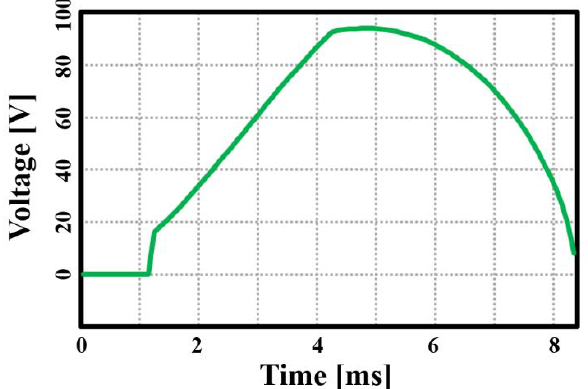
Figure 6. Voltage waveform between contacts without a splitter plate.